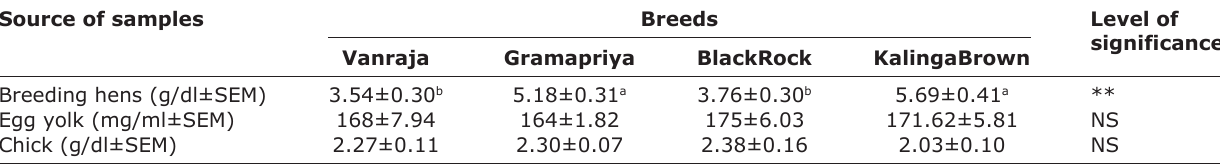
Table-2: Total protein levels in breeding hens, egg yolk and chicks in four different breeds of poultry. Source of samples